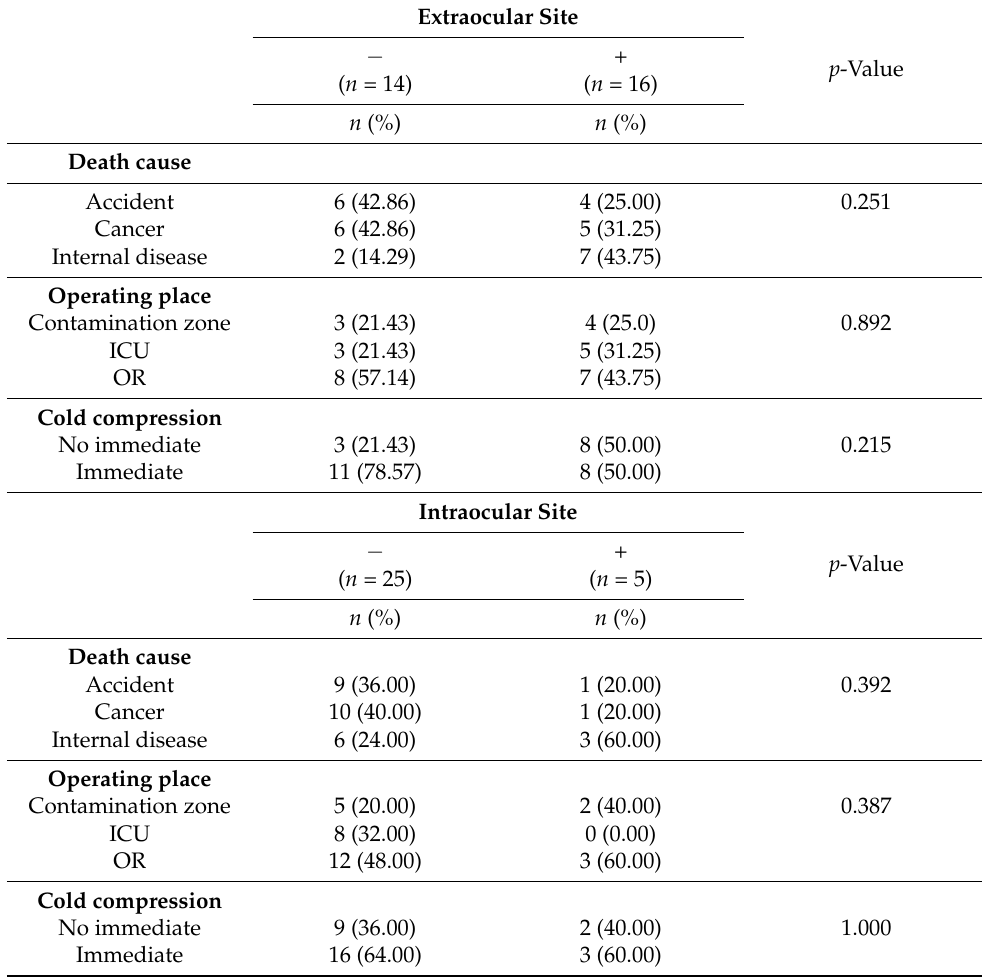
Table 3. Correlation between the Donor-Associated Factors and Microbiological Test Results at the Extraocular and Intraocular Sides of the